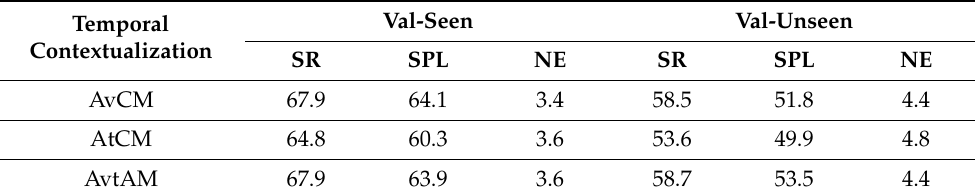
Figure 9. Different temporal contextualization modules: ( a ) attended visual context module (AvCM), ( b ) attended textual context module (AtCM), and the ( c ) attended visual–textual action module (AvtAM). Table 2. Comparison among different temporal contextualization